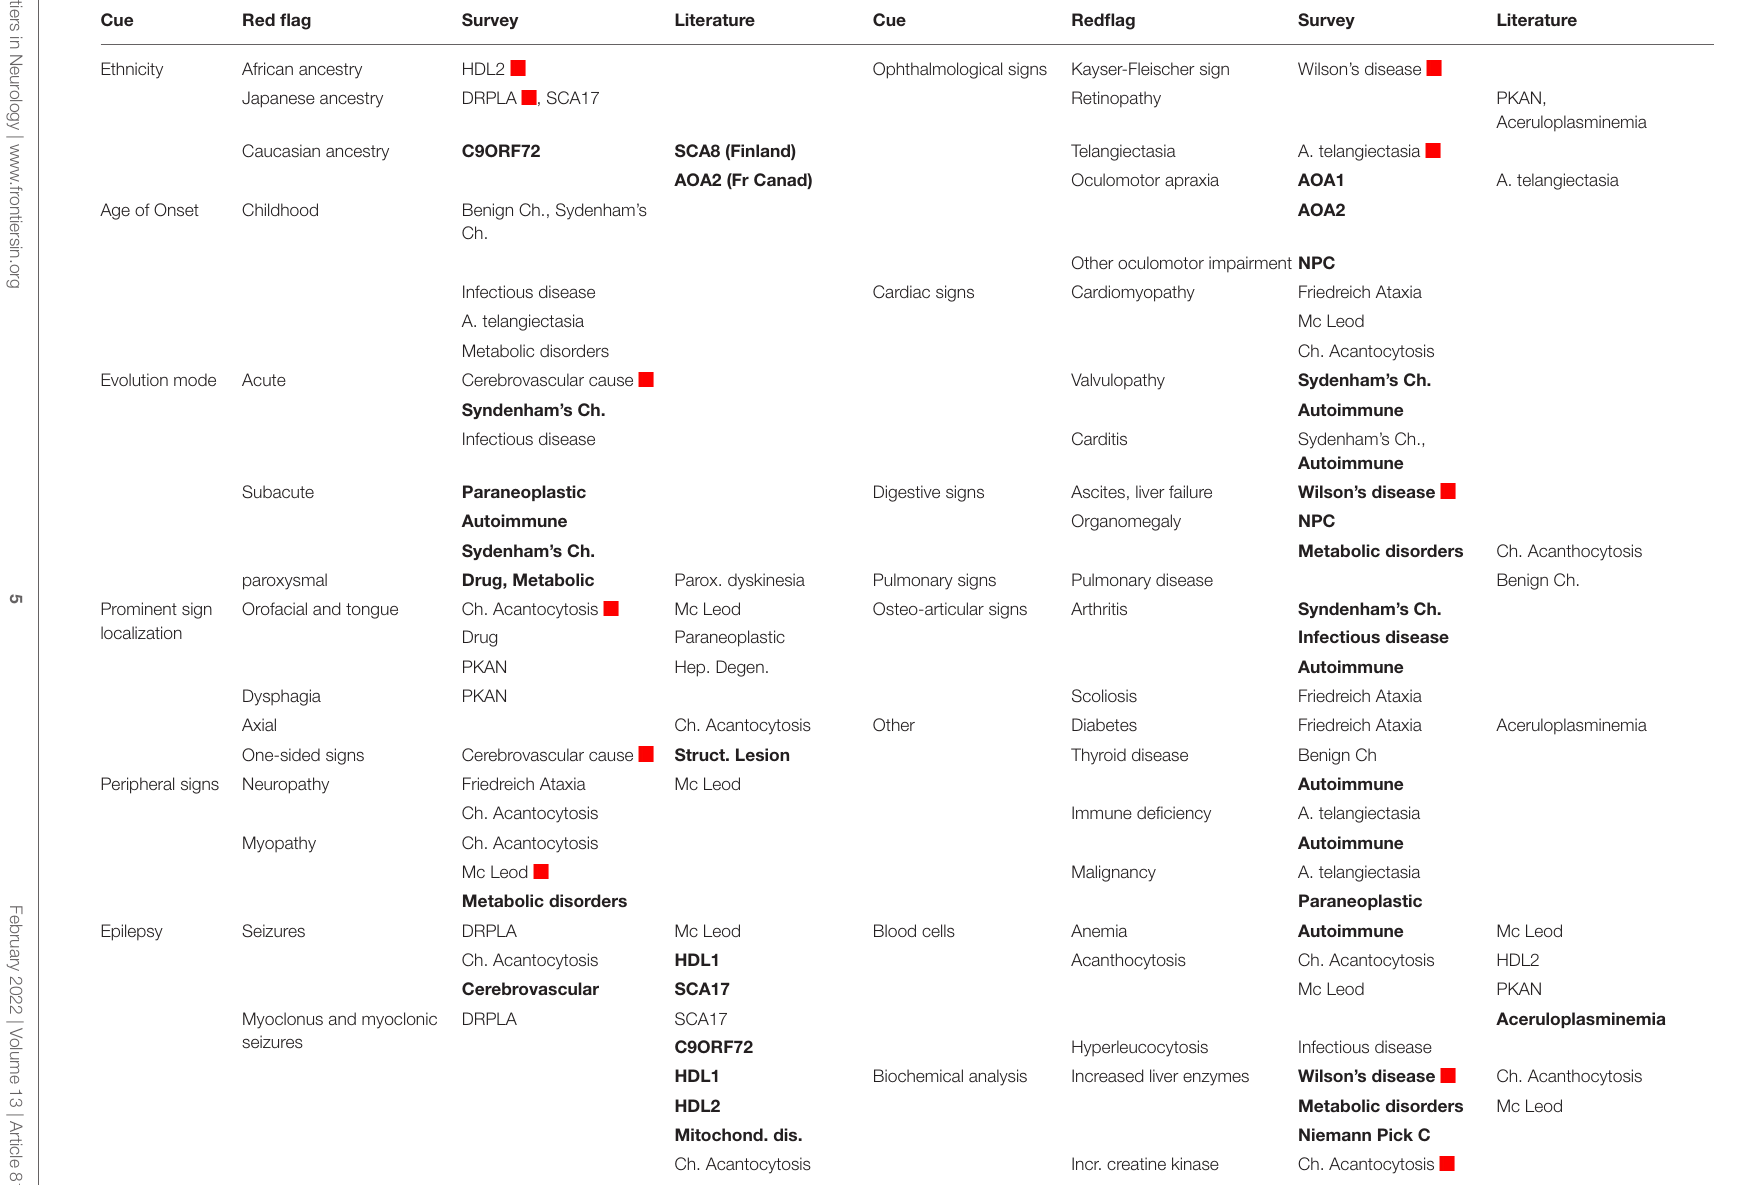
TABLE 2 | Red flags identified in the survey and literature, as well as suggested diagnoses.